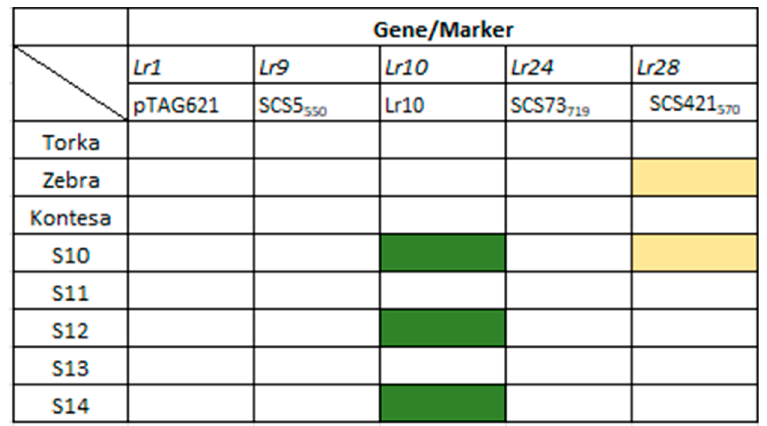
Figure 7. Identification of gene markers associated with wheat resistance to P. triticina in bread wheat cultivars and five spelt as the parental forms of bread wheat-spelt breeding lines.